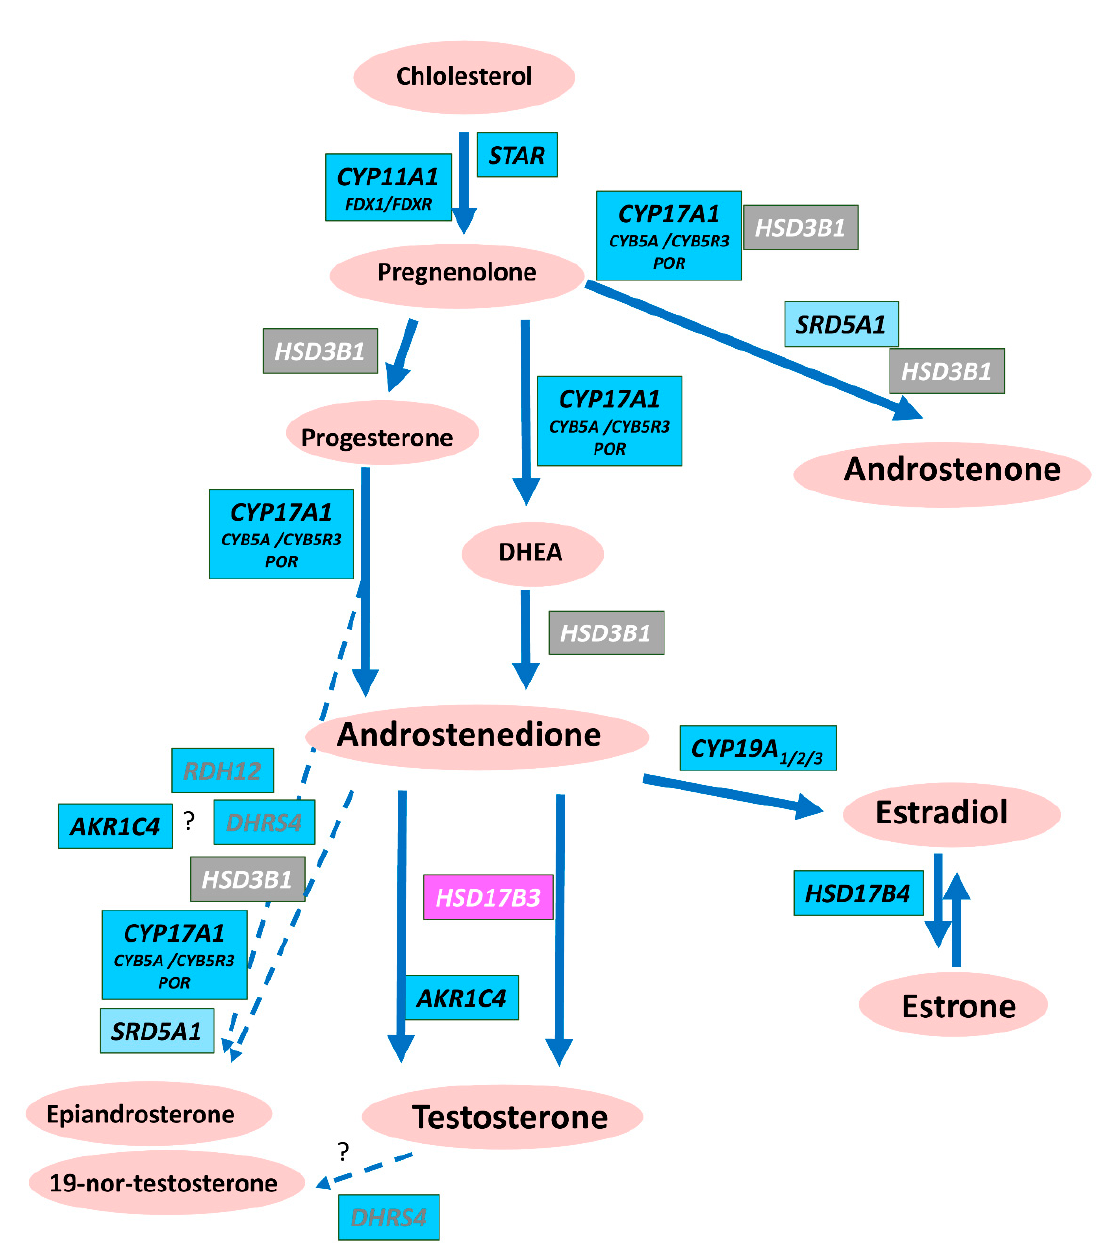
Figure A1. Landscape of genes involved in the pathway of sex steroids production in the porcine testis. The initial step to produce all sex steroids in the testes is the transformation of cholesterol in pregnenolone. In all mammals, the transformation of pregnenolone in androstenedione opens the common pathway to estrogens and androgens. Pregnenolone is also the starting product in the androstenone pathway. Epiandrosterone, 19-nor-testosterone, testosterone and androstenedione are androgens. 17 β -estradiol and estrone are estrogens. Androstenone is a pheromone. The pathways of the biosynthesis of epiandrosterone and 19-nor-testosterone are not completely known.